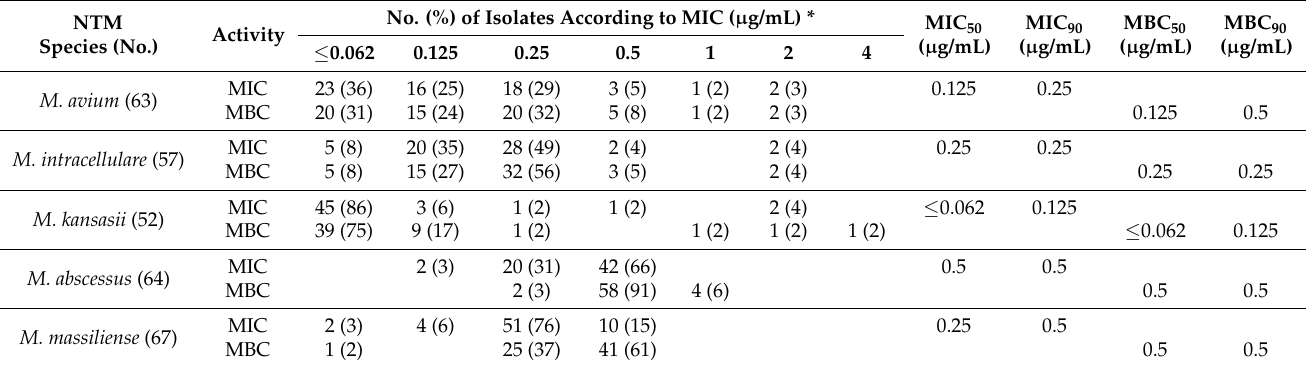
Table 1. MIC 50 , MIC 90 , MBC 50 , and MBC 90 values of clofazimine for 303 clinical NTM isolates. NTM Species